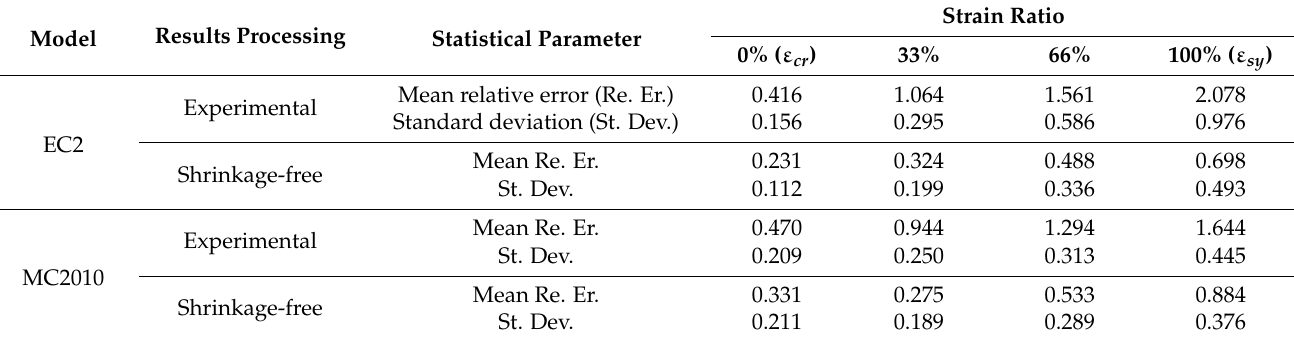
Table 3. Mean relative error and standard deviation values for all specimens at different strain levels.